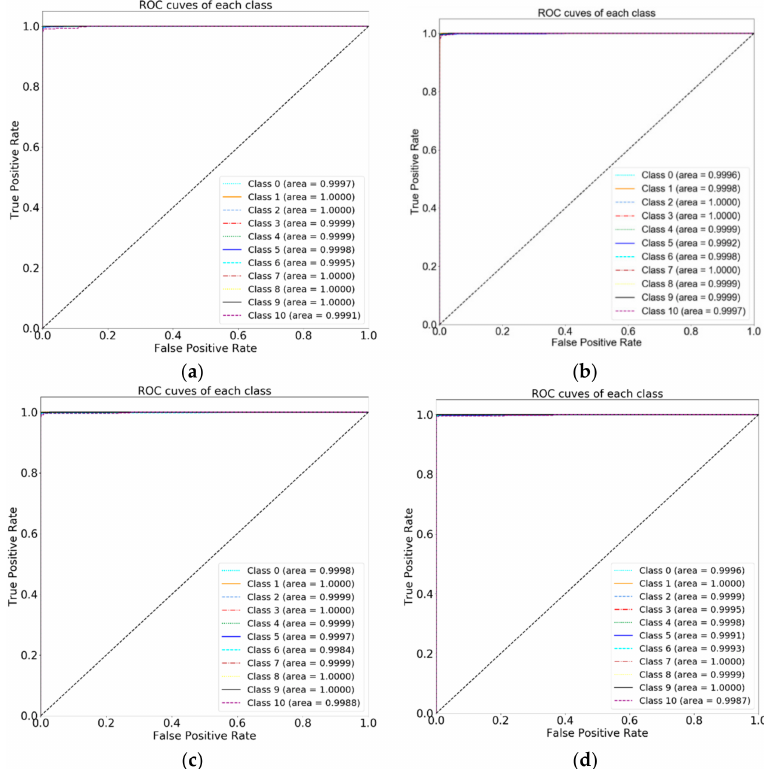
Figure 7. Receiver operating characteristics (ROC) of the CIC-IDS 2017 dataset: ( a ) proposed process flow, ( b ) standard process flow, ( c ) SFS-DT-based feature selection, and ( d ) SBS-DT-based feature